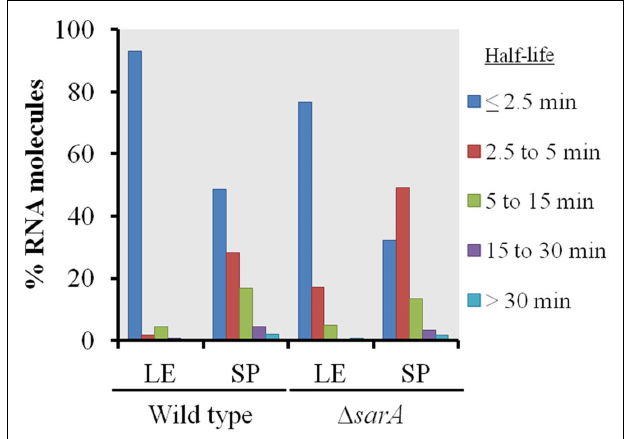
FIGURE 1 | Global transcript turnover properties of wild type and Δ sarA cells. The global RNA turnover properties of UAMS-1 (wild type) and isogenic Δ sarA ( Δ sarA ) cells during late-exponential (LE) and stationary phase (SP) growth are graphed. Percentages of total transcripts with